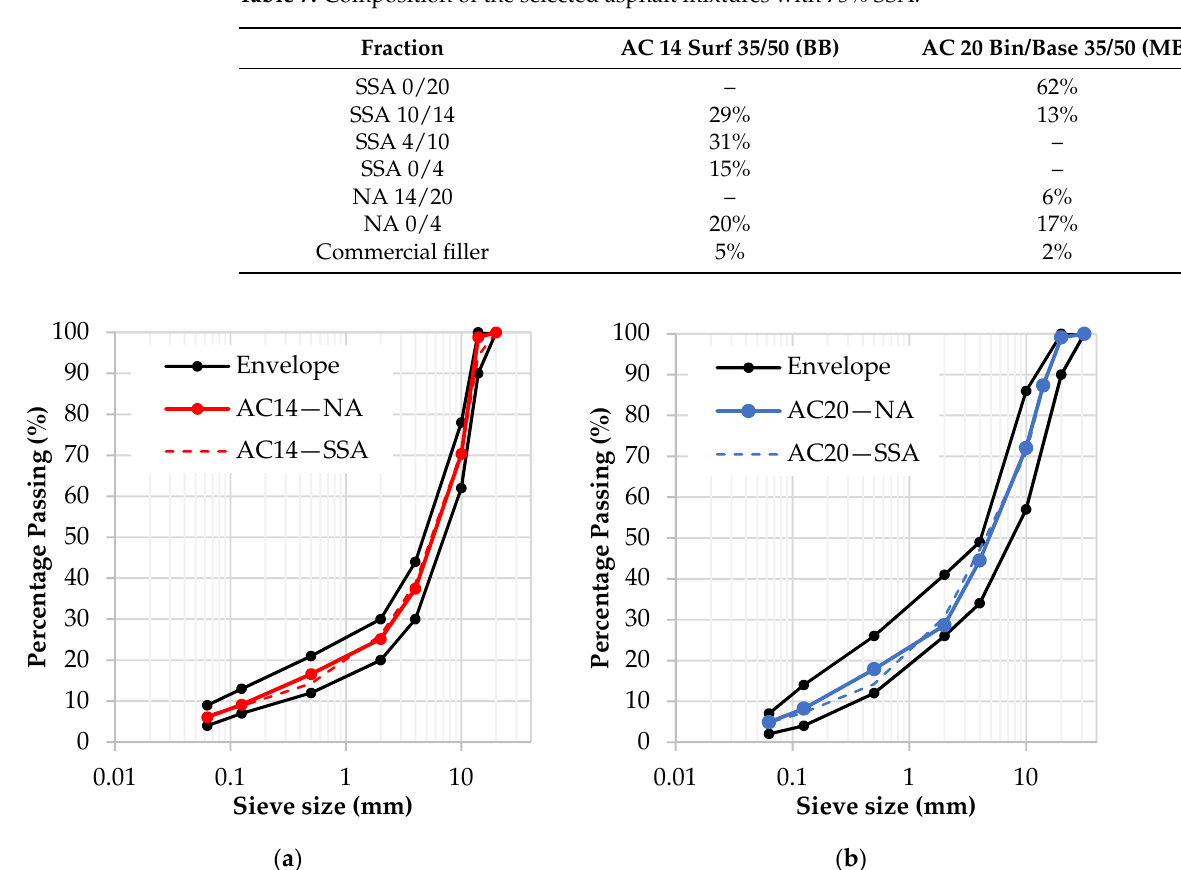
Table 7. Composition of the selected asphalt mixtures with 75% SSA.